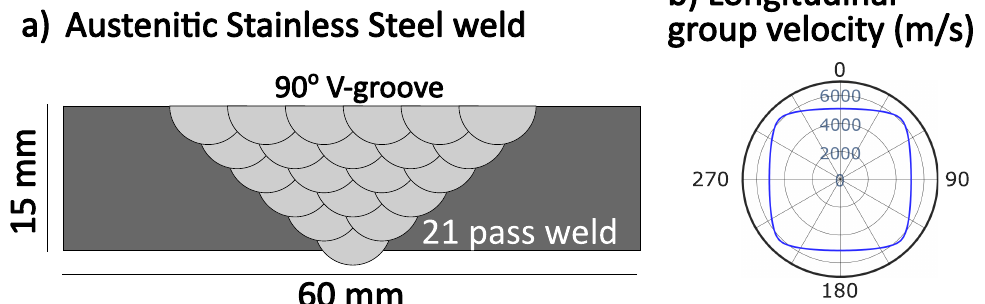
Figure 1. ( a ) Schematic of the considered weld geometry, a 90 ◦ V-groove austenitic stainless steel weld constructed from 21 weld passes; ( b ) the group velocity curve used to model austenitic stainless steel using a cubic stiffness tensor where c 11 = 203.6 GPa, c 12 = 133.5 GPa and c 44 = 129.8 GPa and the density is ρ = 7874 kg/m 3 (from